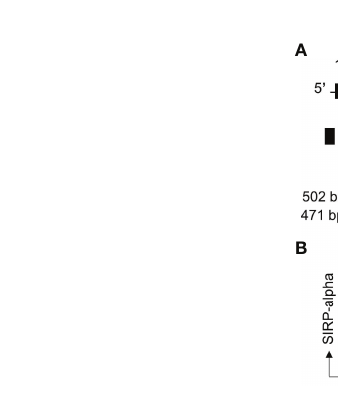
FIGURE 2 | Blockade of SIRP-alpha expression suppressed the development of murine ALI. (A) Schematic diagram and genotyping of SIRP-alpha phenotypes in mice by PCR. 502 bp: SIRP-alpha +/+ (WT); 471 bp: SIRP-alpha -/- (KO); 502/471 bp: SIRP-alpha +/- . (B) Flow cytometry analysis of SIRP-alpha expression on CD11b+ myeloid cells in BAL of naïve WT and KO mice. Representative dot plot. (C) H&E staining for lung pathology. Mice with ALI were established by intratracheal injection of 5 mg/kg LPS for 2 days. Mice treated with PBS were controls. Representative photograph of each treatment with 100 × magni fi cation. (D) Quantitative analysis of lung pathology by H&E staining. The score of severity was evaluated by scale from 0 to 4 in terms of alveolar edema, hemorrhage, alveolar septal thickening and in fi ltration of polymorphonuclear leukocytes. (E) Total cell counts in BAL. Data was presented as mean ± standard deviation, *p